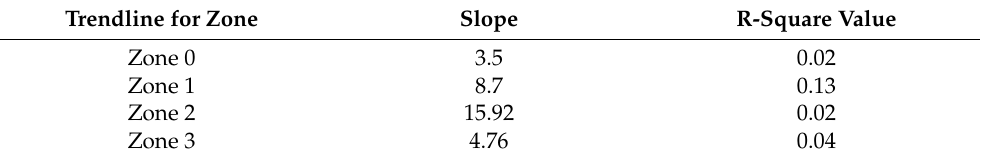
Table 4. Linear Regression Results When DMSP-VIIRS Nighttime Light is Considered.